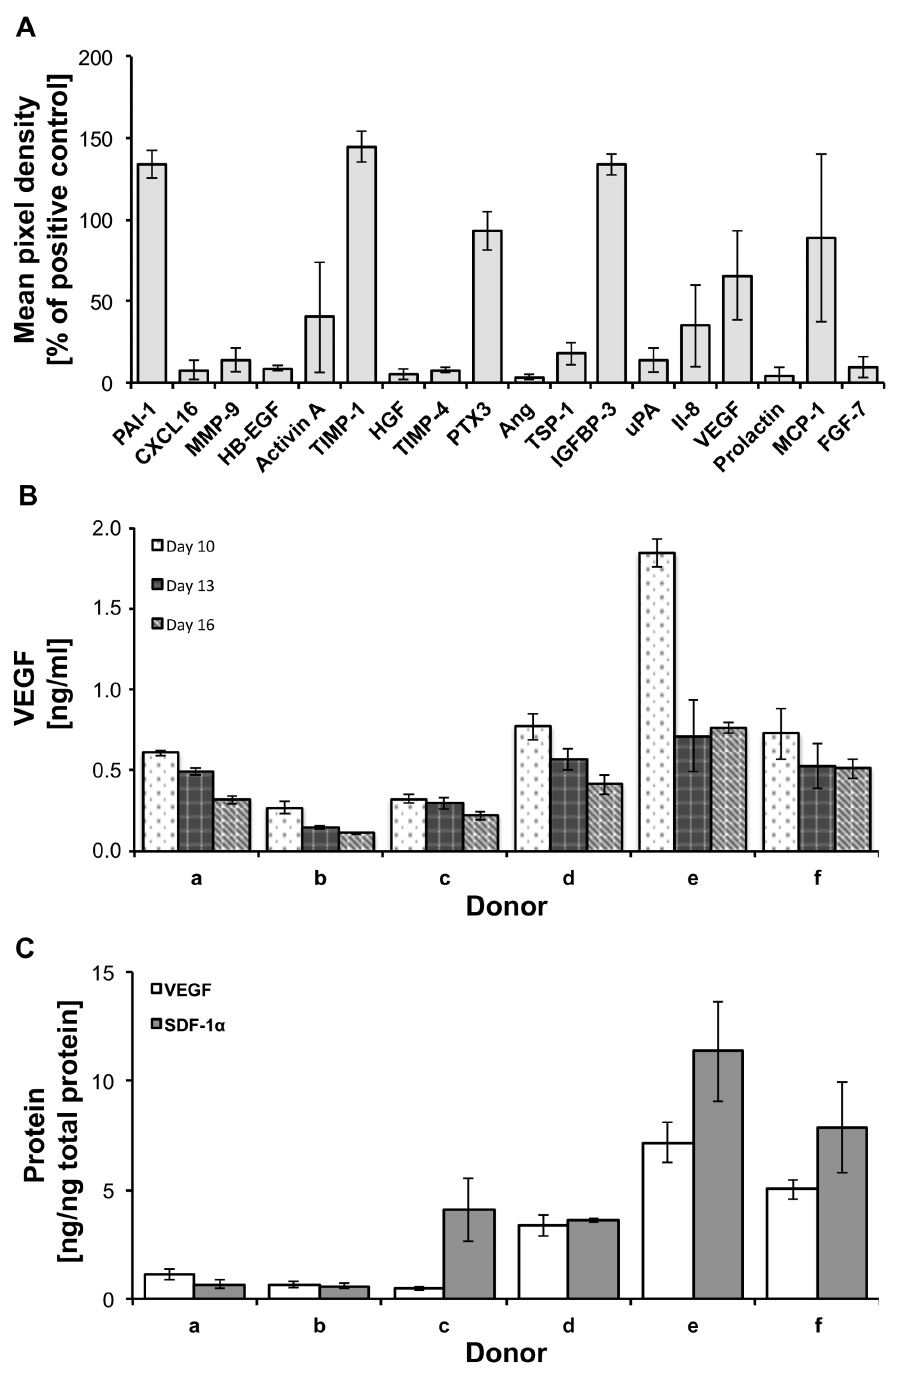
Figure 5. Cytokine release from ASC-filled sutures. A cytokine array detected a multitude of different cytokines released from ASC-filled sutures (A). VEGF was constantly released to cell culture medium for at least 16 days (B). VEGF and SDF-1 a were detected in protein extracts of ASC- filled sutures 16 days after seeding (C).